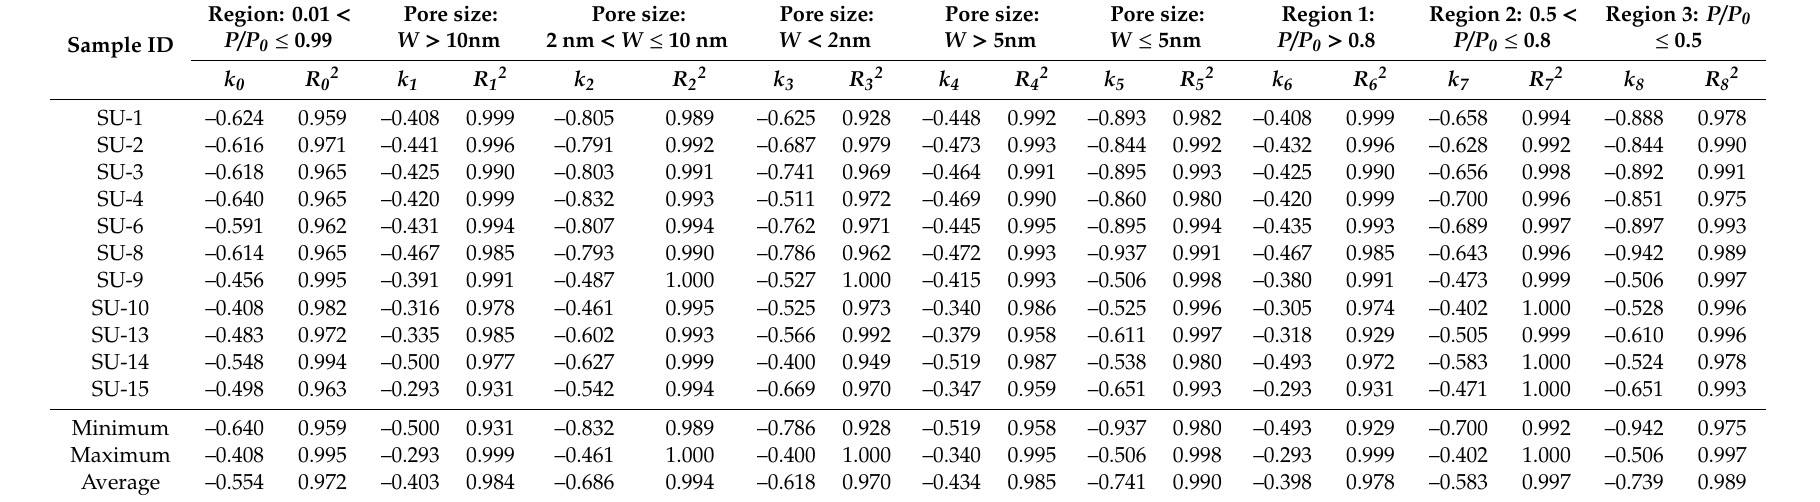
Table 3. Slop ( k ) and root mean square error ( R 2 ) obtained from the plot of ln( V ) vs . ln[( P 0 / P